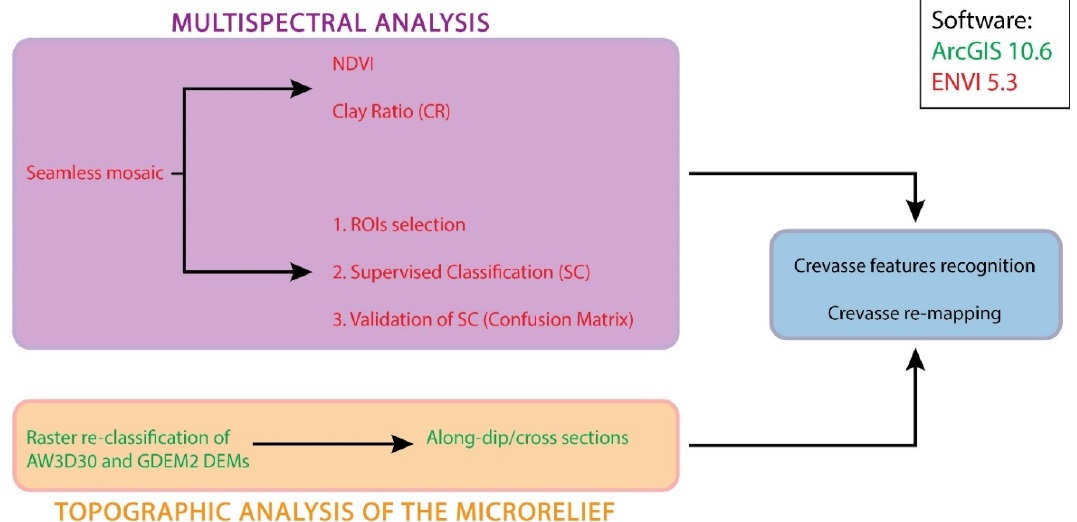
Figure 4. Example for producer and user accuracy (sensu Banko 1998) for a typical landforms association of a crevasse splay.